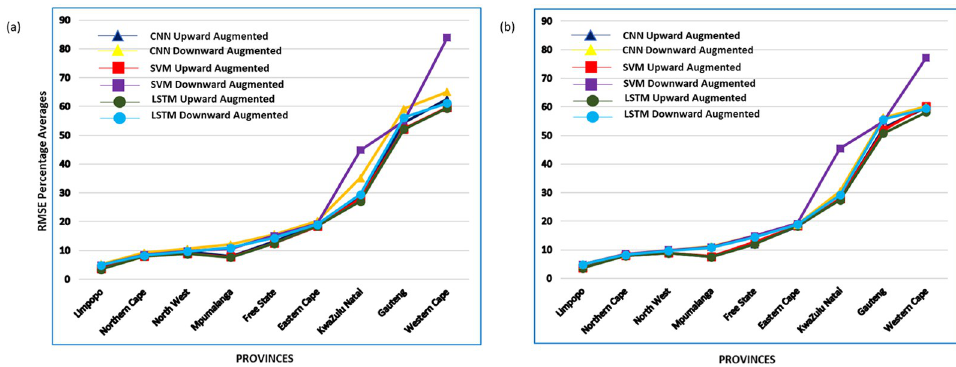
Fig 8. Provincial results of the ML methods with the augmented data-sets in Experiments II & III. (a) & (b): Results of the predictions with the augmented data-sets for each province (a) represents the results with grid-search tuned parameters and (b) represents the results with REVAC tuning parameters. Low RMSE averages indicate better task performance and vice-versa.